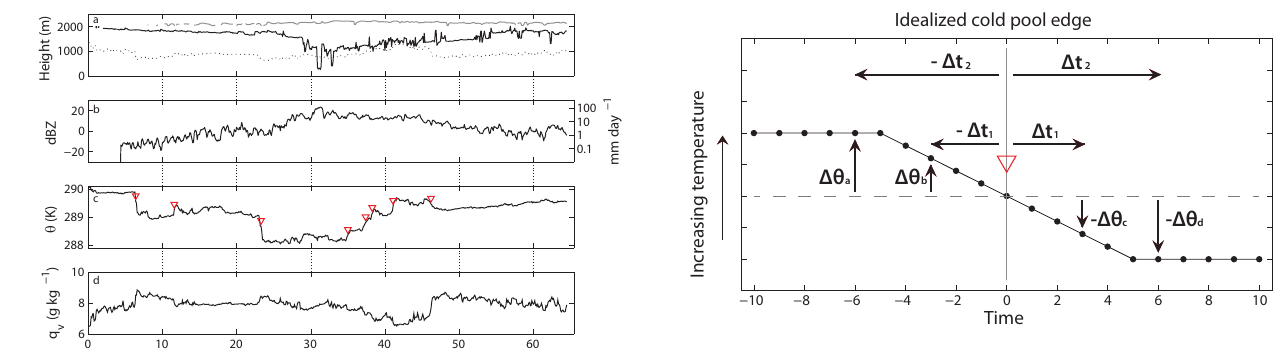
Fig. 2. Schematic showing how cold pools are identified in the po- tential temperature ( θ ) time series. Along the x axis, time t increases to the right, while along the y axis, θ increases upward. In this case, the data point at time t = 0 is identified a cold pool if 1θ a , 1θ b , 1θ c , and 1θ d satisfy the